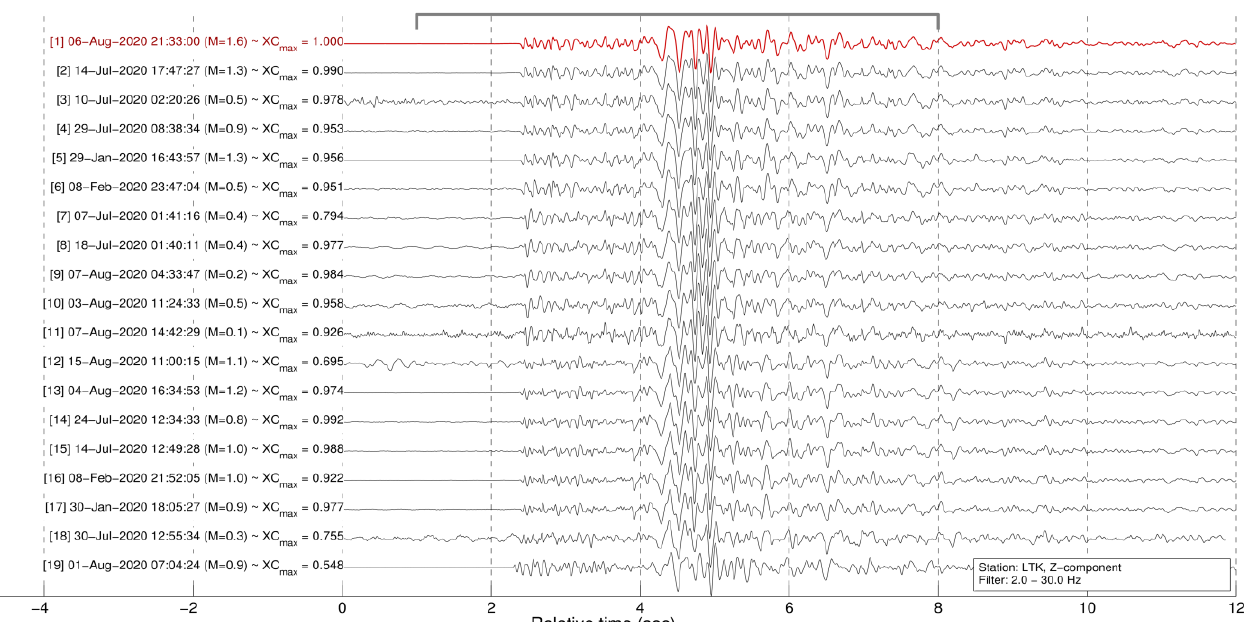
Figure A7. Waveforms of template “2020-08-06-21-33-02” (top, red) and 18 associated detections (black), belonging to multiplet #23 of CAT3, formed with farthest-neighbor linkage at a similarity threshold of 0.50. The recordings are from the vertical component of station LTK, filtered between 2 and 30 Hz. Events of this multiplet are associated with spatial group #3 (blue in Figure 3a), mainly